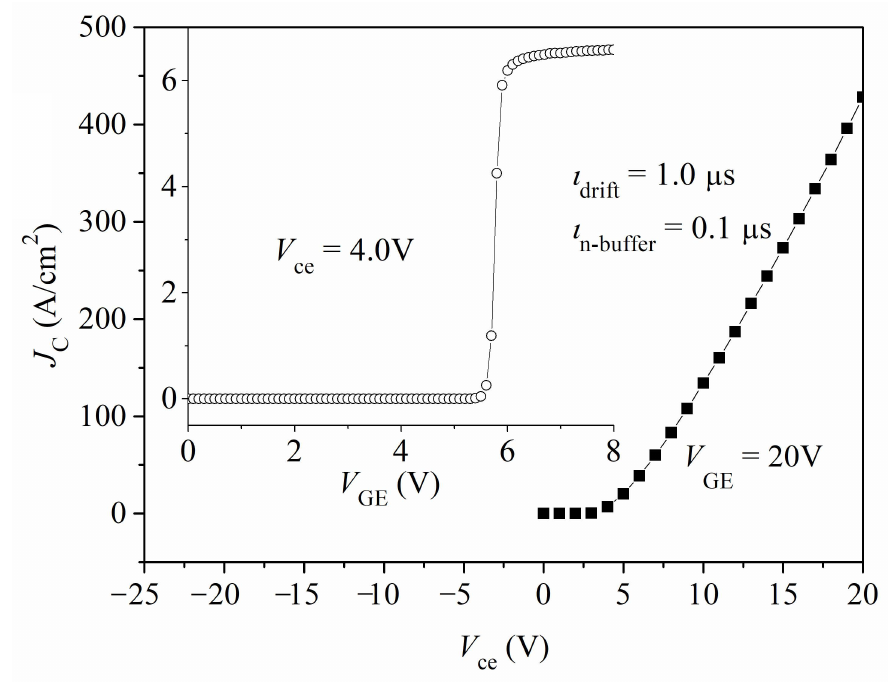
Figure 2. Transfer and I–V characteristics.